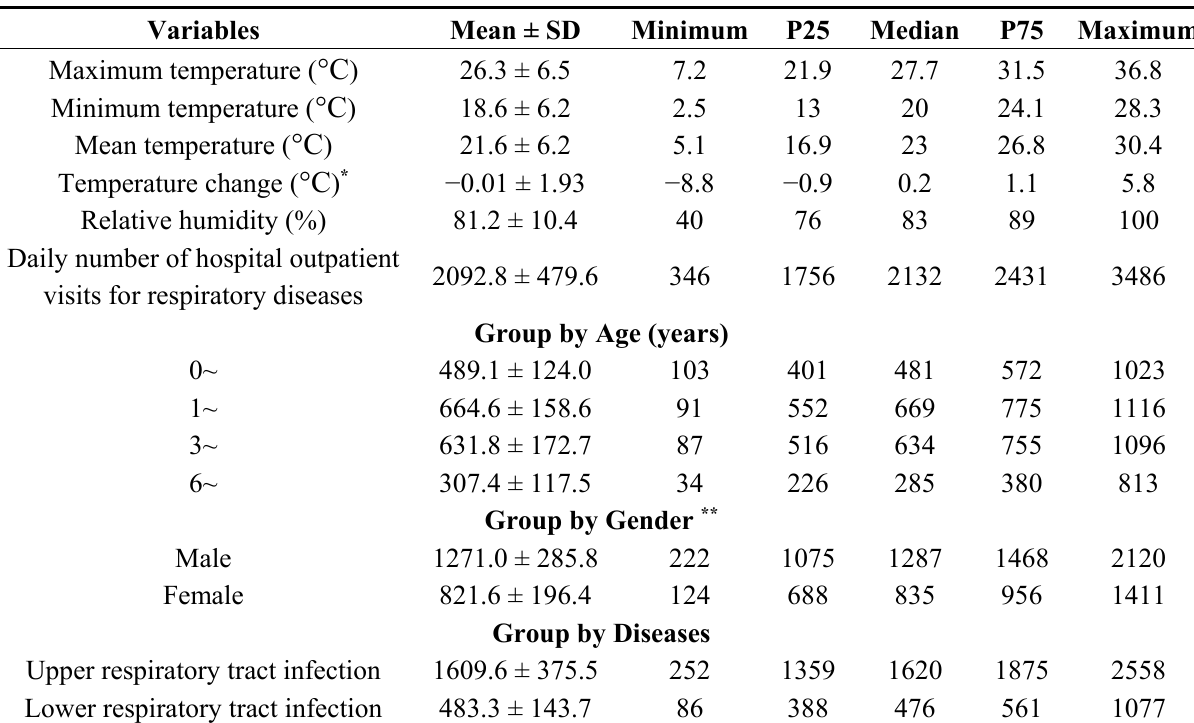
Table 1. Summary statistics of ambient temperature and outpatient visits for respiratory tract infections (RTIs) in